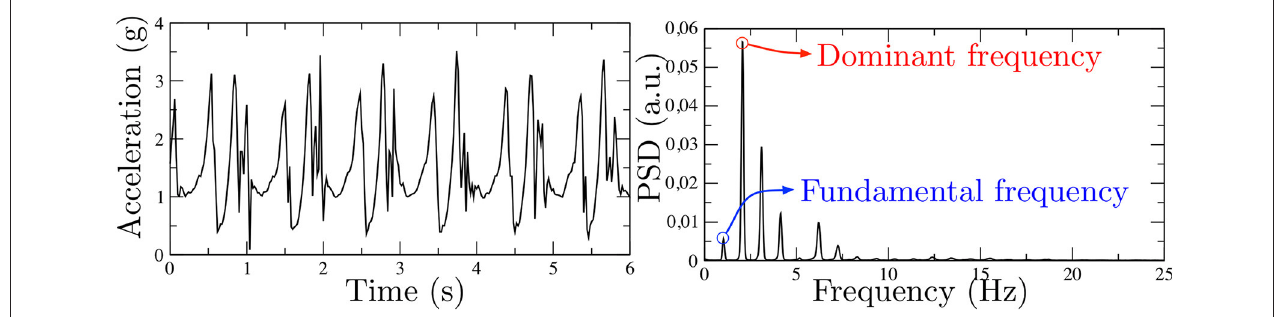
FIGURE 2 | Real gait acceleration signal in time domain (Left) and frequency domain (Right) , where a clear harmonic structure can be